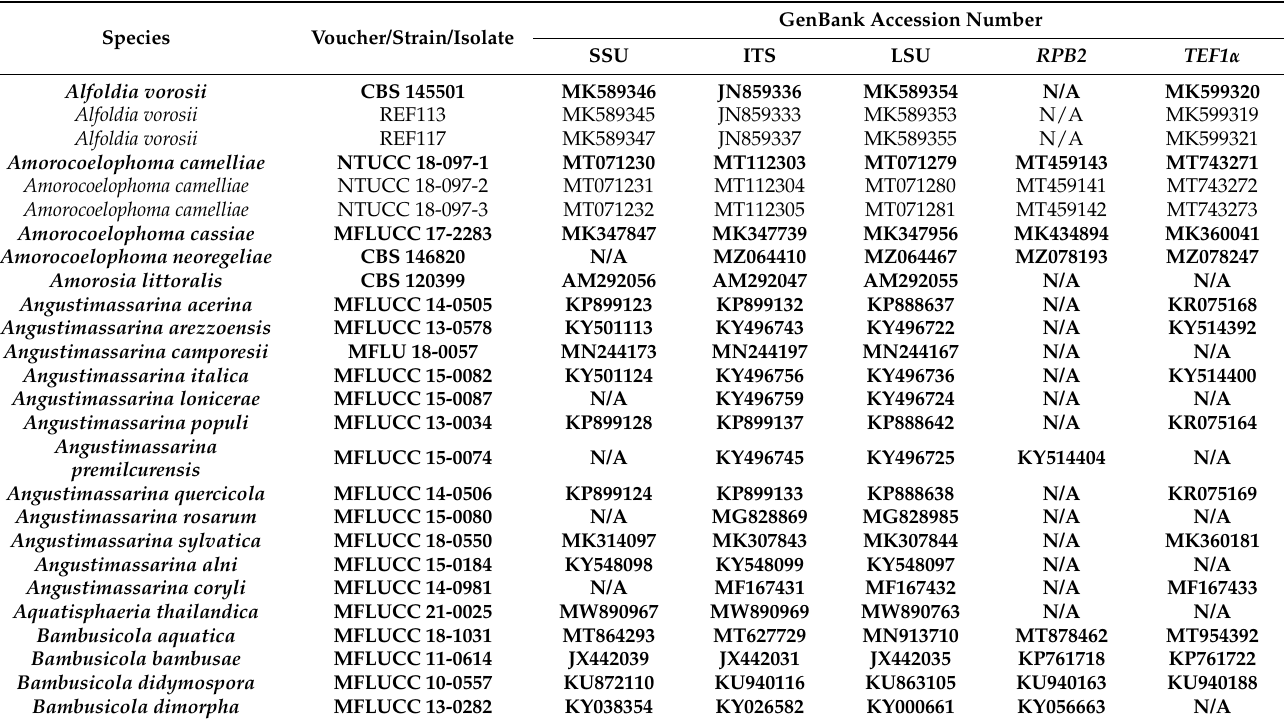
Table 2. Taxa used in the phylogenetic analyses and their GenBank accession numbers. Newly generated sequences are indicated with * and the ex-type strains are in